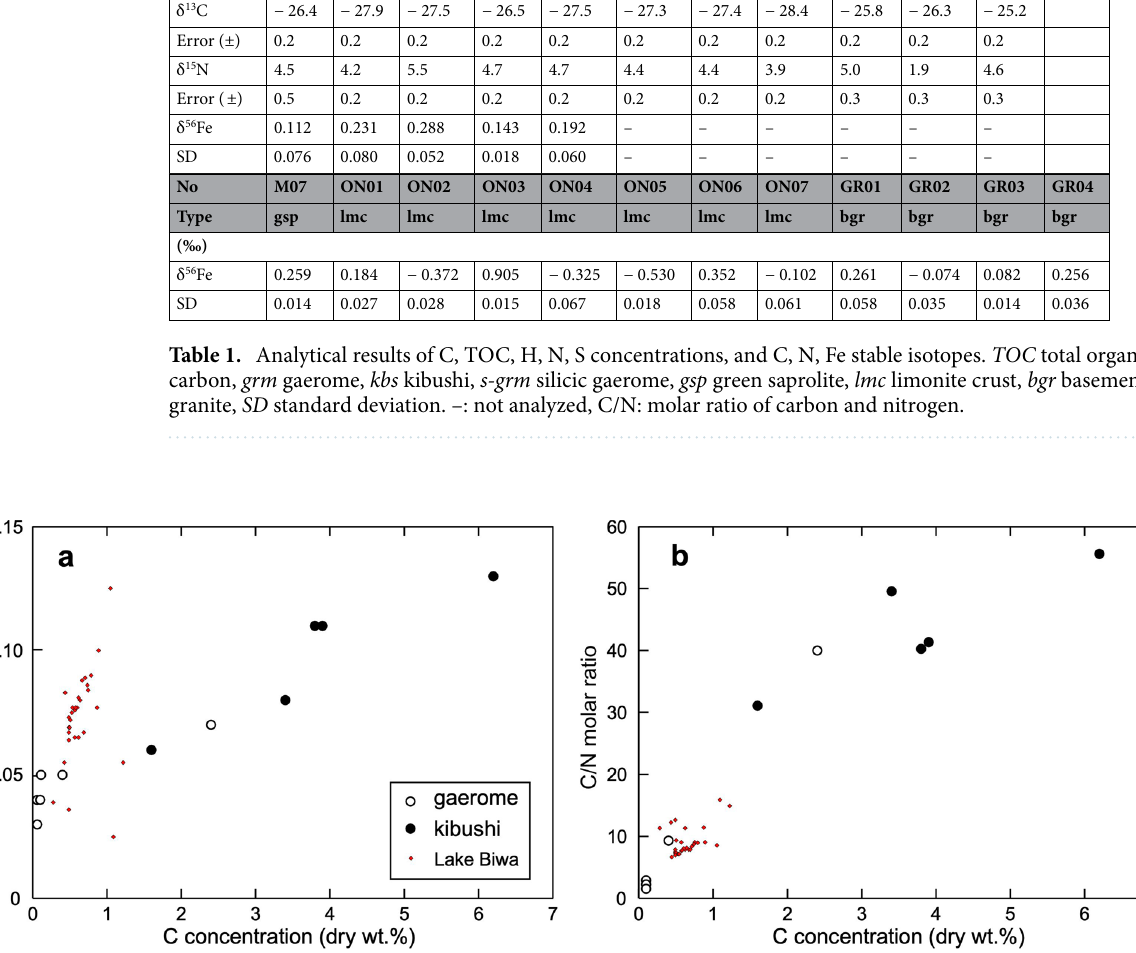
Figure 10. Graphs showing relationships between carbon and nitrogen in gaerome and kibushi clay. ( a ) C versus N (dry wt%), and ( b ) C (dry wt%) versus C/N molar ratio. The composition of Lake Biwa sediments 20 , which are modern lacustrine sediments 80 km west of the Seto area, is shown for comparison with kibushi and gaerome